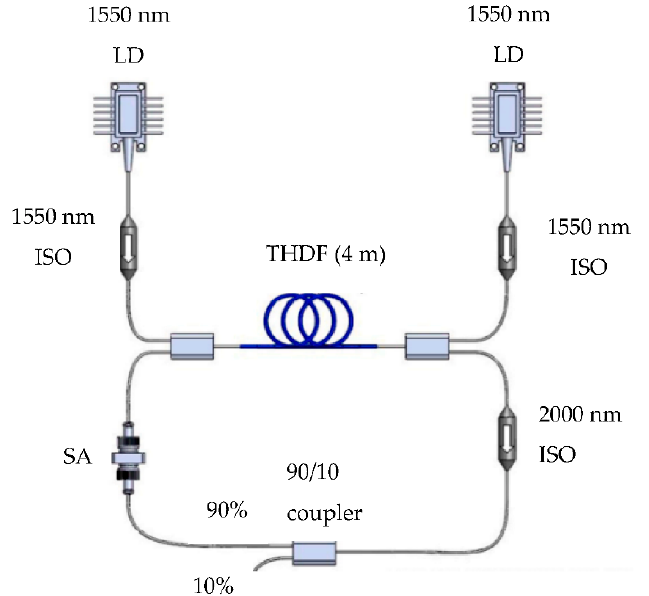
Figure 5. Schematic diagram of the mode ‐ locked THDFL experimental setup. Adapted with permis ‐ sion from Ref. [28]. 2021, S. N. F. Zuikafly”. sion from Ref. [28]. 2021, S. N. F.